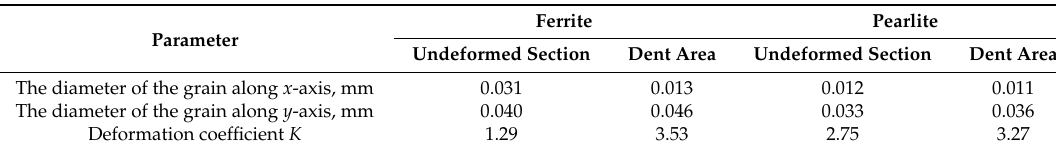
Table 6. The average grain size and grain deformation